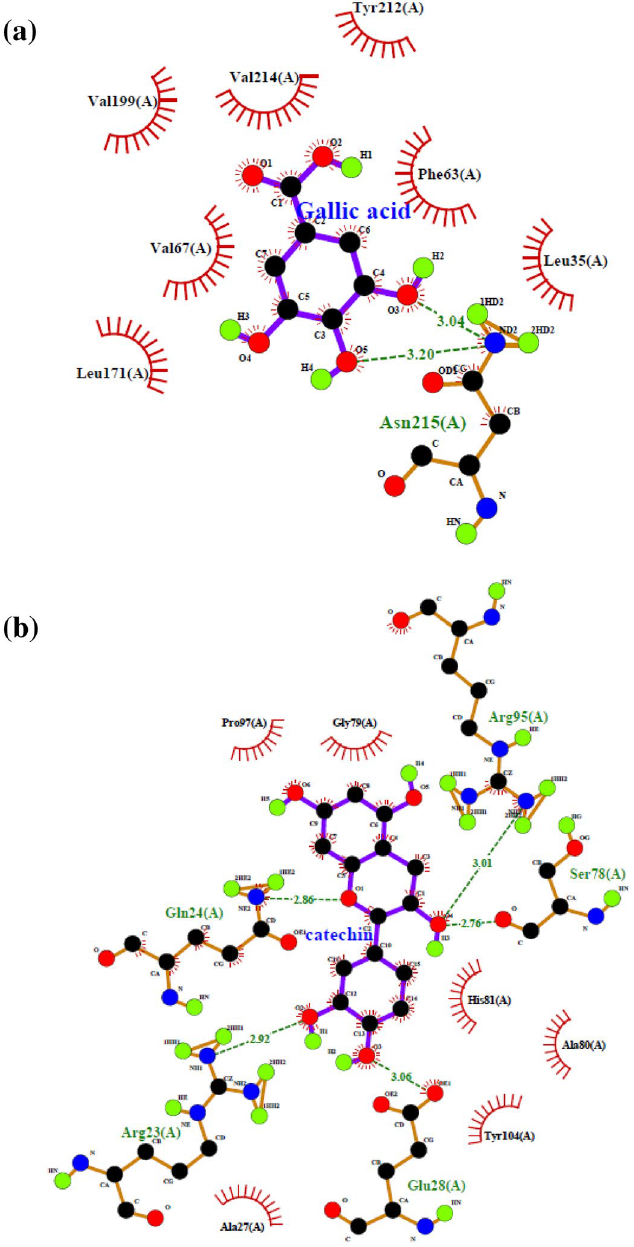
Figure 10. LigPlot for the interactions in the AQP-3-ligand complexes showing hydrogen bond with their equivalent distance and non-ligand residues involved in the hydrophobic interaction ( a ) gallic acid and ( b )